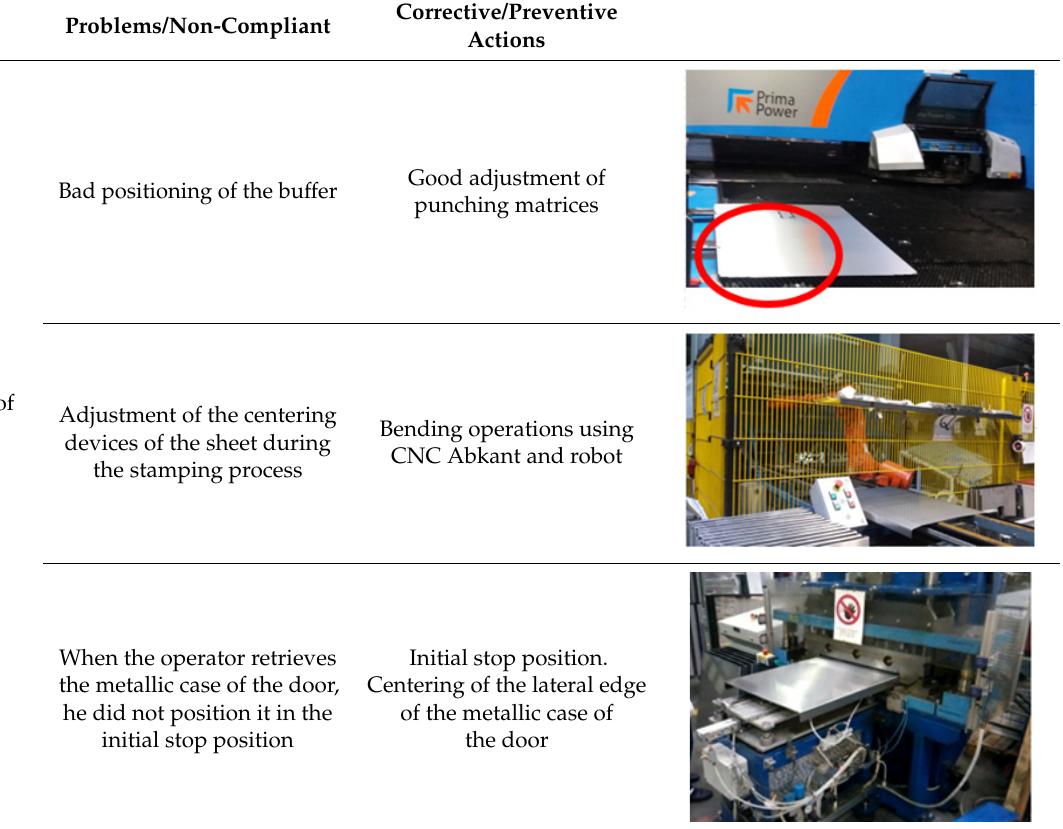
Table 8. Corrective actions.